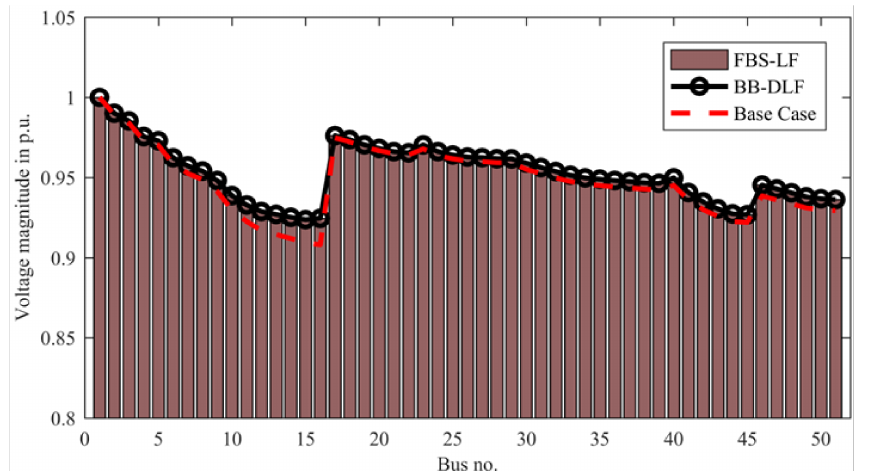
Figure 9. Comparison of voltage profile of PDN as obtained by FBS-LF and BB-DLF when a 300 kVAr D-STATCOM is allocated to bus 16 of 51-bus PDN.